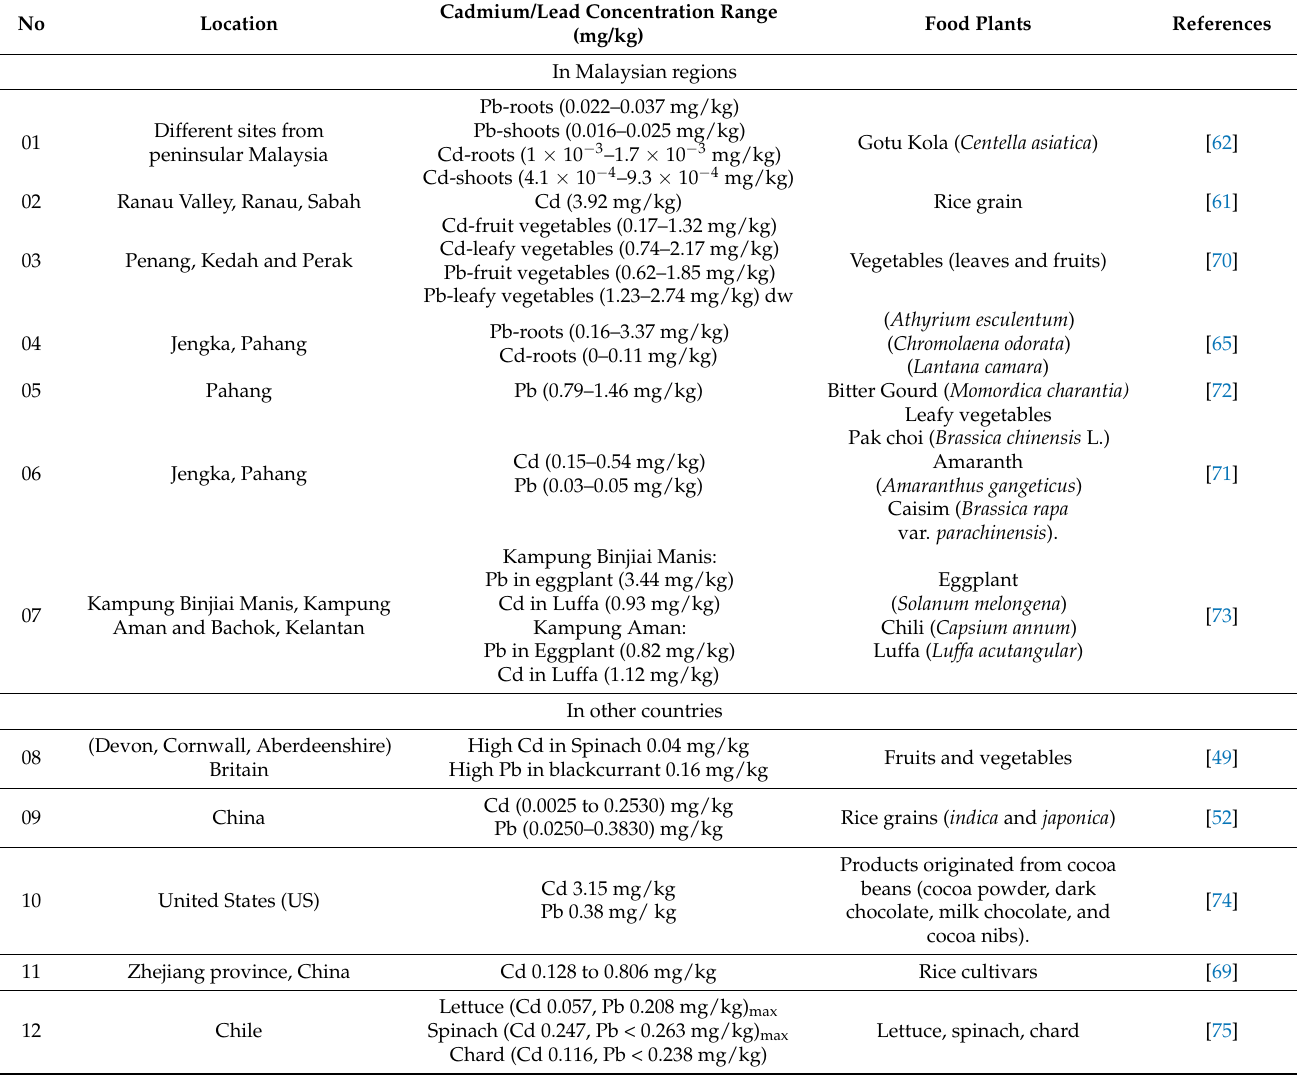
Table 4. Cadmium and lead concentration ranges in different parts of the food plants from previous